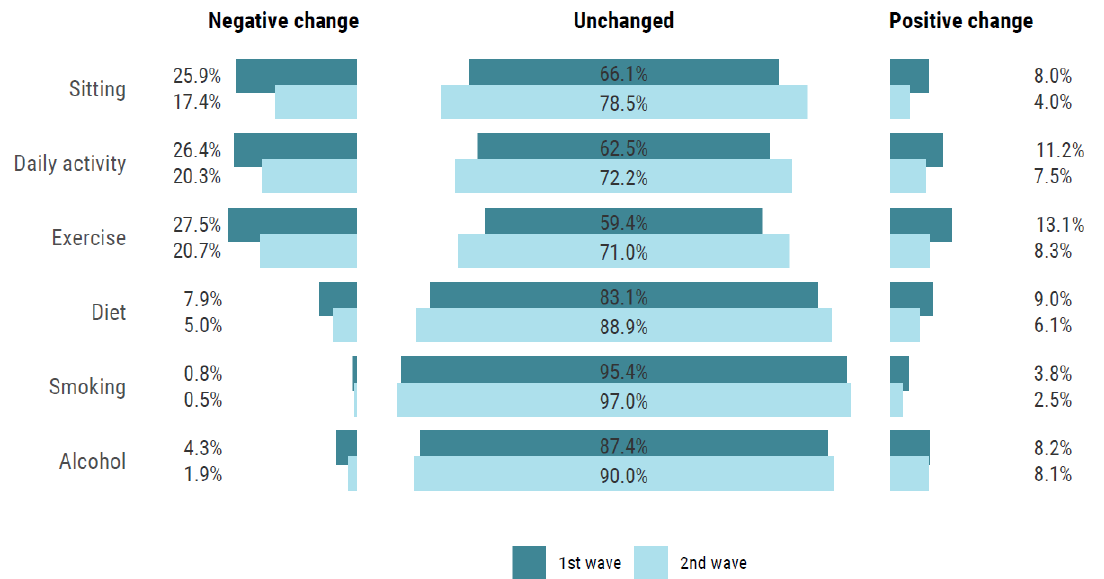
Figure 1. Self-reported change in lifestyle habits comparing wave 1 (April to June) and wave 2 (September to December).